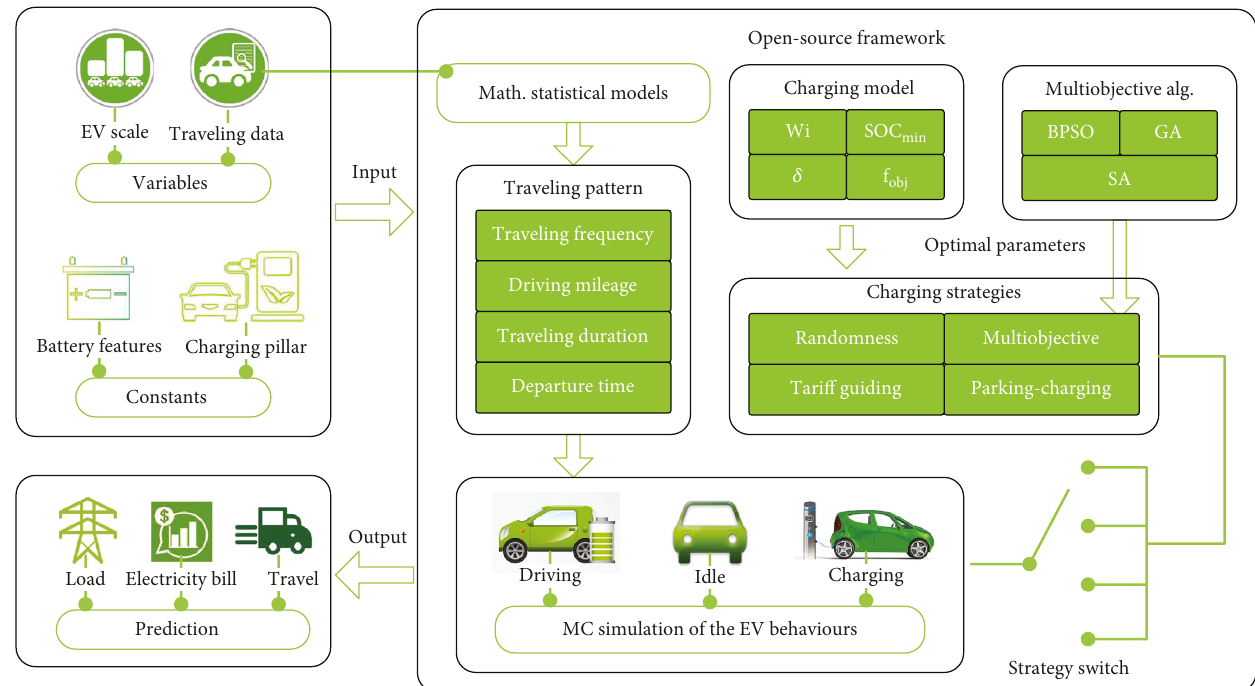
Figure 2: The framework for EVs traveling and charging behaviours